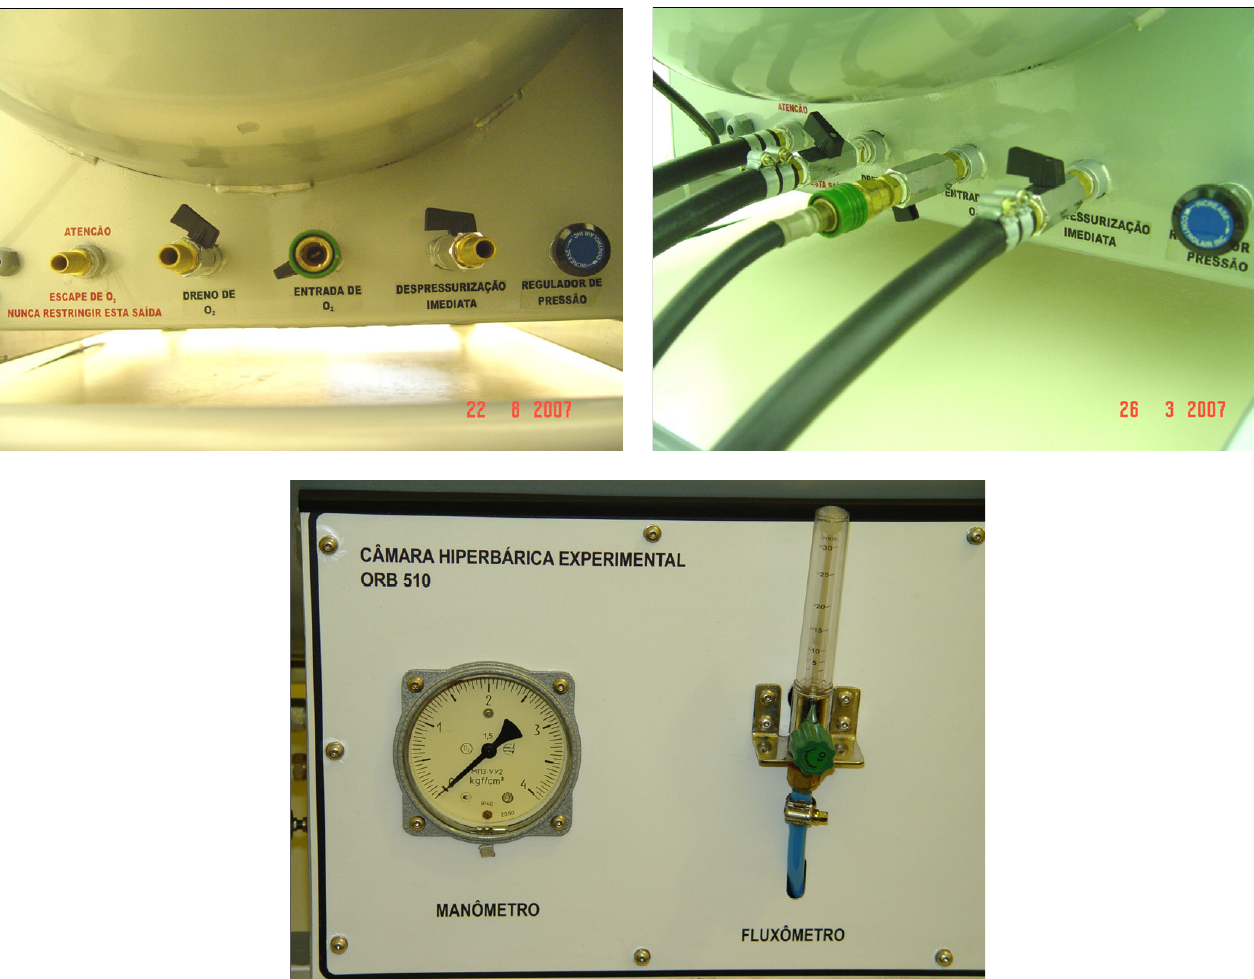
FIGURE 4 – Posterior view (top - left) of the hyperbaric chamber with the escape valve, the drain and the entrance of oxygen, depressurization valve and pressure controller. On the top-right side, the connected hardwired nets. - Detail of the frontal panel with the manometer and fluximeter for renewal of the oxygen